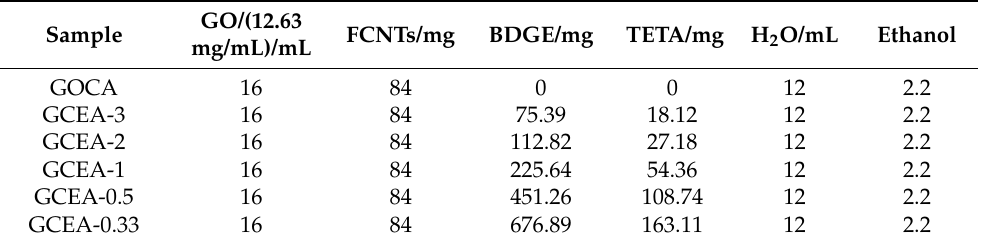
Table 1. Sample composition.